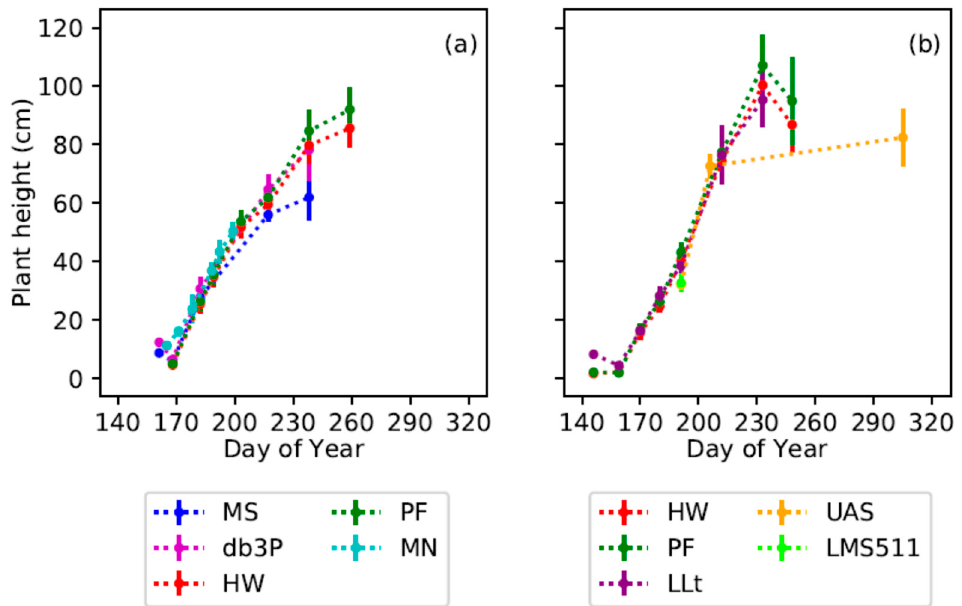
Figure 6. Calculated plant height (cm) means and standard deviation obtained from the Honeywell (HW), Pepperl+Fuchs (PF), MaxSonar (MS), db3 Pulsar (db3P), and manual measurements (MN) across the growing season in 2016 ( a ), and the means and standard deviations for the Honeywell (HW), Pepperl+Fuchs (PF), LidarLite v3 (LLt), unmanned aerial system images (UAS), and SICK- (LMS511) sensors used to collect plant height data across the 2017 growing season ( b ).